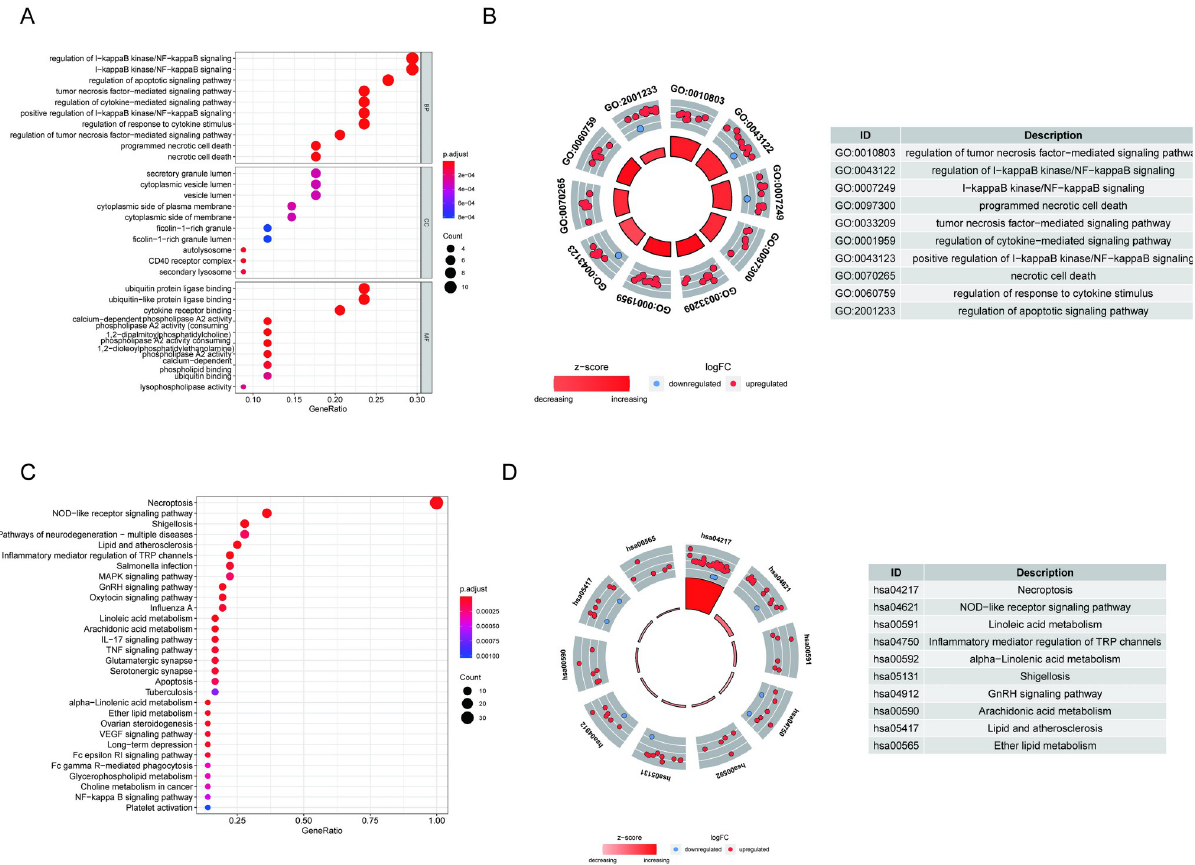
Fig 2. GO and KEGG analysis. (A) GO function enrichment. Biological process, BP; Cellular component, CC; Molecular function, MF. (B) The GO circle shows the scatter map of the logFC of the specified gene. (C) KEGG functional enrichment. (D) The KEGG circle shows the scatter map of the logFC of the specified gene. Blue: downregulated; red: